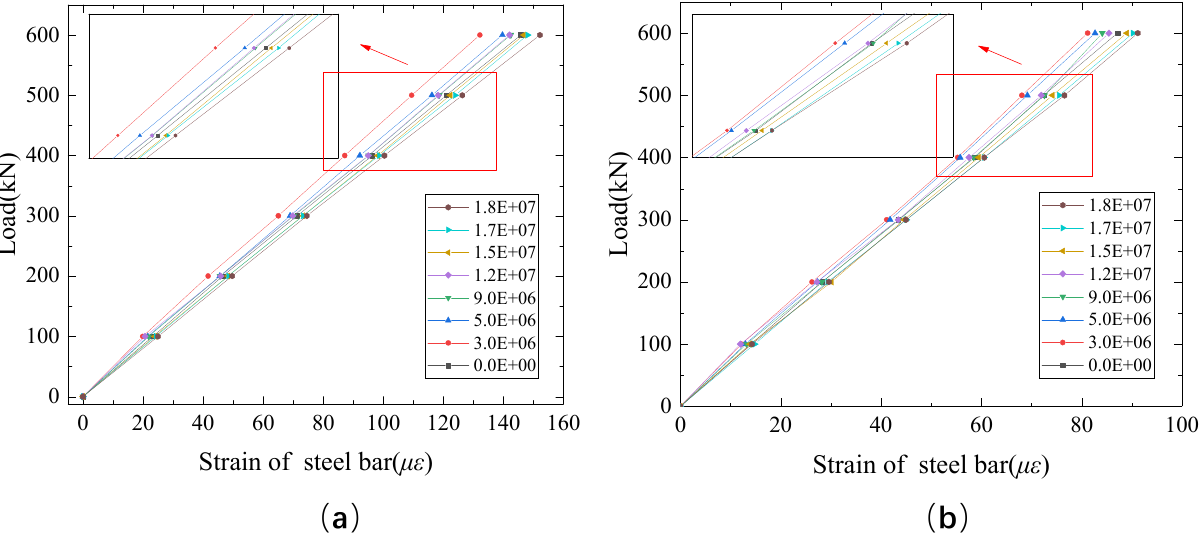
Figure 6. Load–strain curve of ordinary steel bar (a) L/2 section; (b) L/4 section.